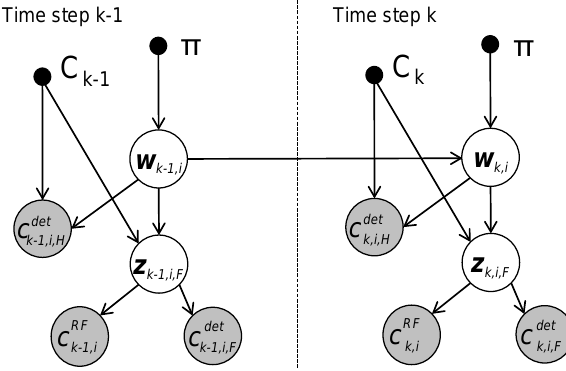
Figure 1. Dynamic Bayes Network for pedestrian tracking. The nodes represent random variables, the edges model dependencies between them. The meaning of the variables is briefly explained on the right and in detail in the text. 3D, we presume a ground plane at a constant height below the camera and expect that pedestrians only move along that plane.